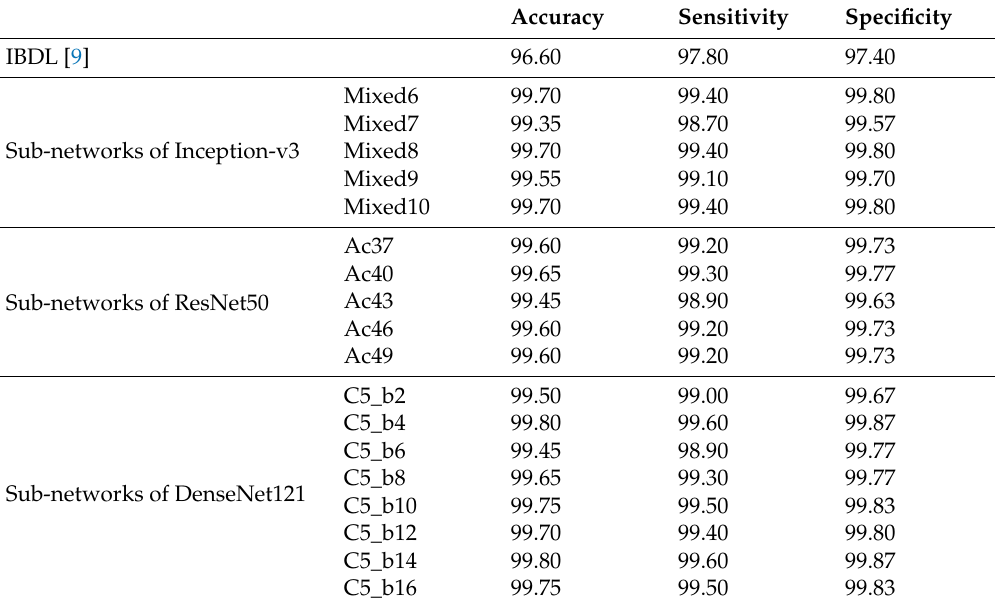
Table 4. The performance (%) of the sub-networks on large-scale